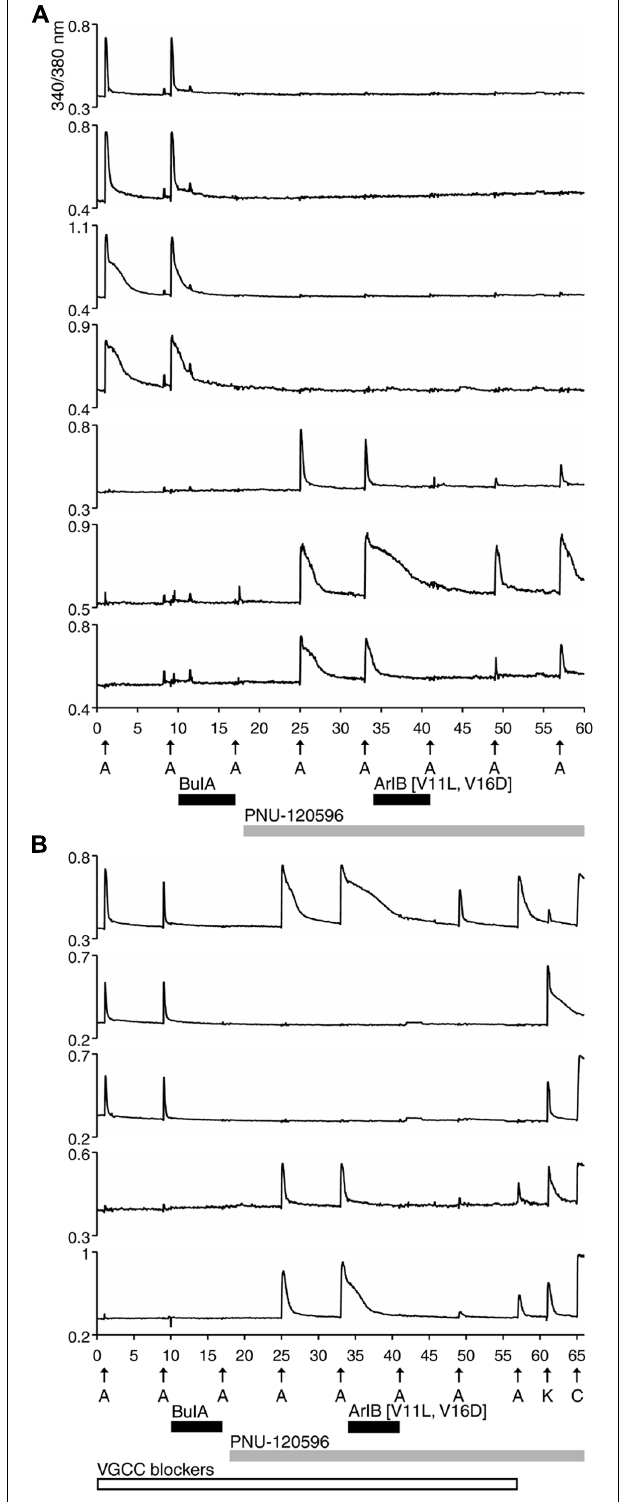
FIGURE 2 | Functional expression of α 7 nAChRs and β 4-containing nAChRs in different rat DRG neuronal subclasses. After two ACh